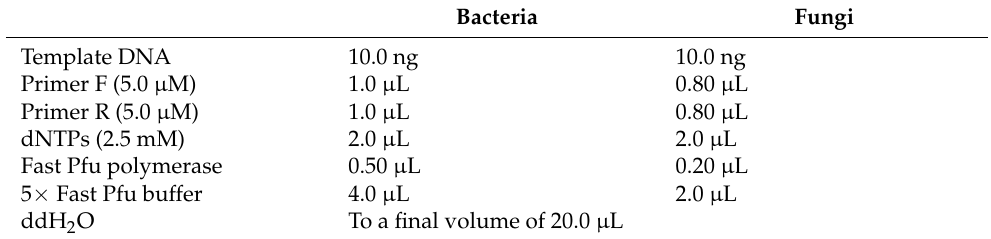
Table 2. The PCR reaction mixture of bacteria and fungi. Bacteria